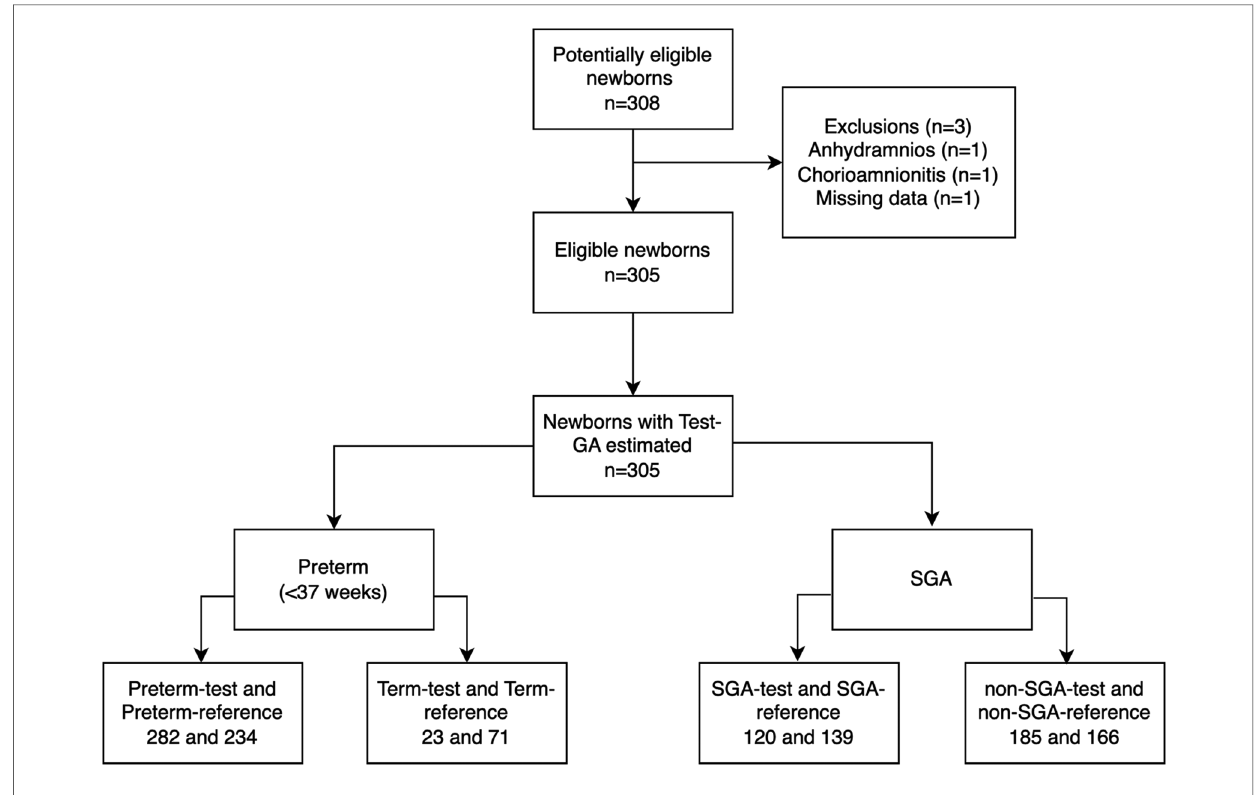
FIGURE 2 STARD diagram of study participants with the primary outcome results. GA, gestational age; SGA, small for gestational